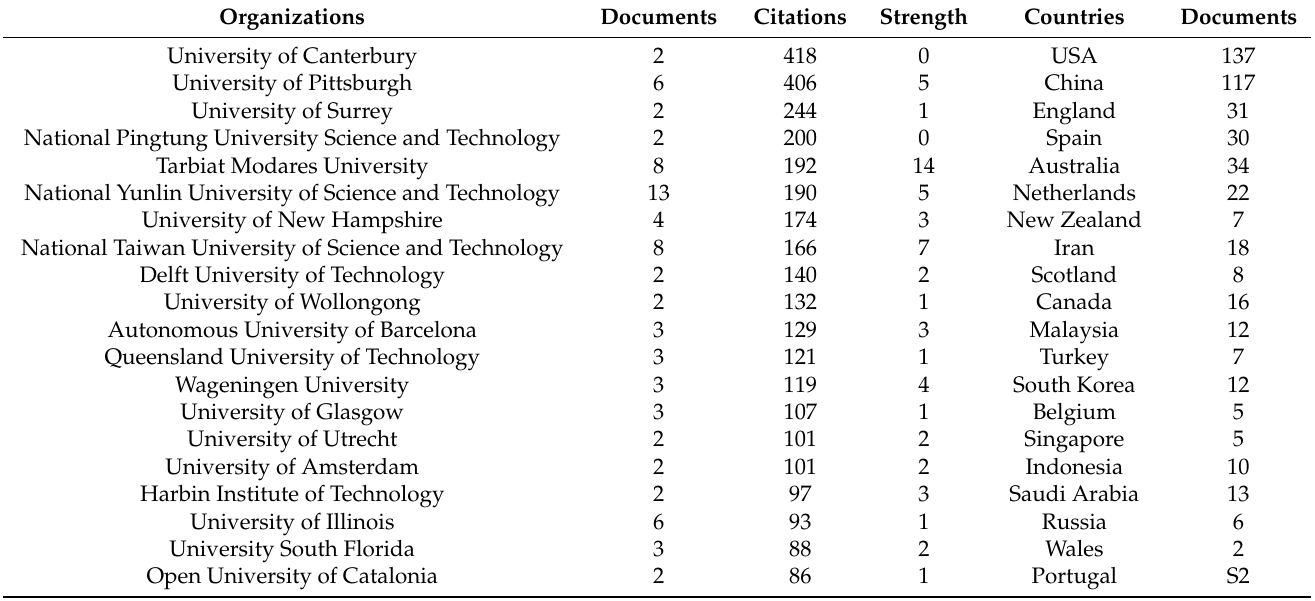
Table 5. The top 20 organizations and countries in the search